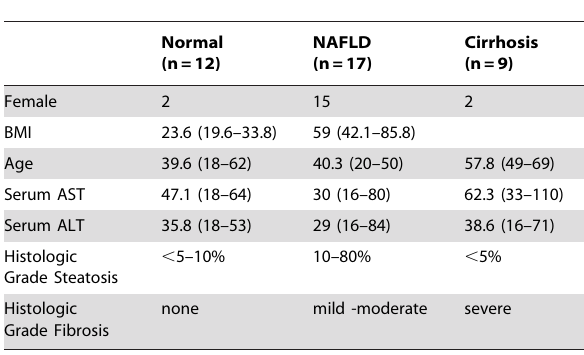
Table 1. Clinical data for sample populations. Patient ages, body mass index (BMI) and serum liver function tests are represented as mean values followed by a range in parentheses.